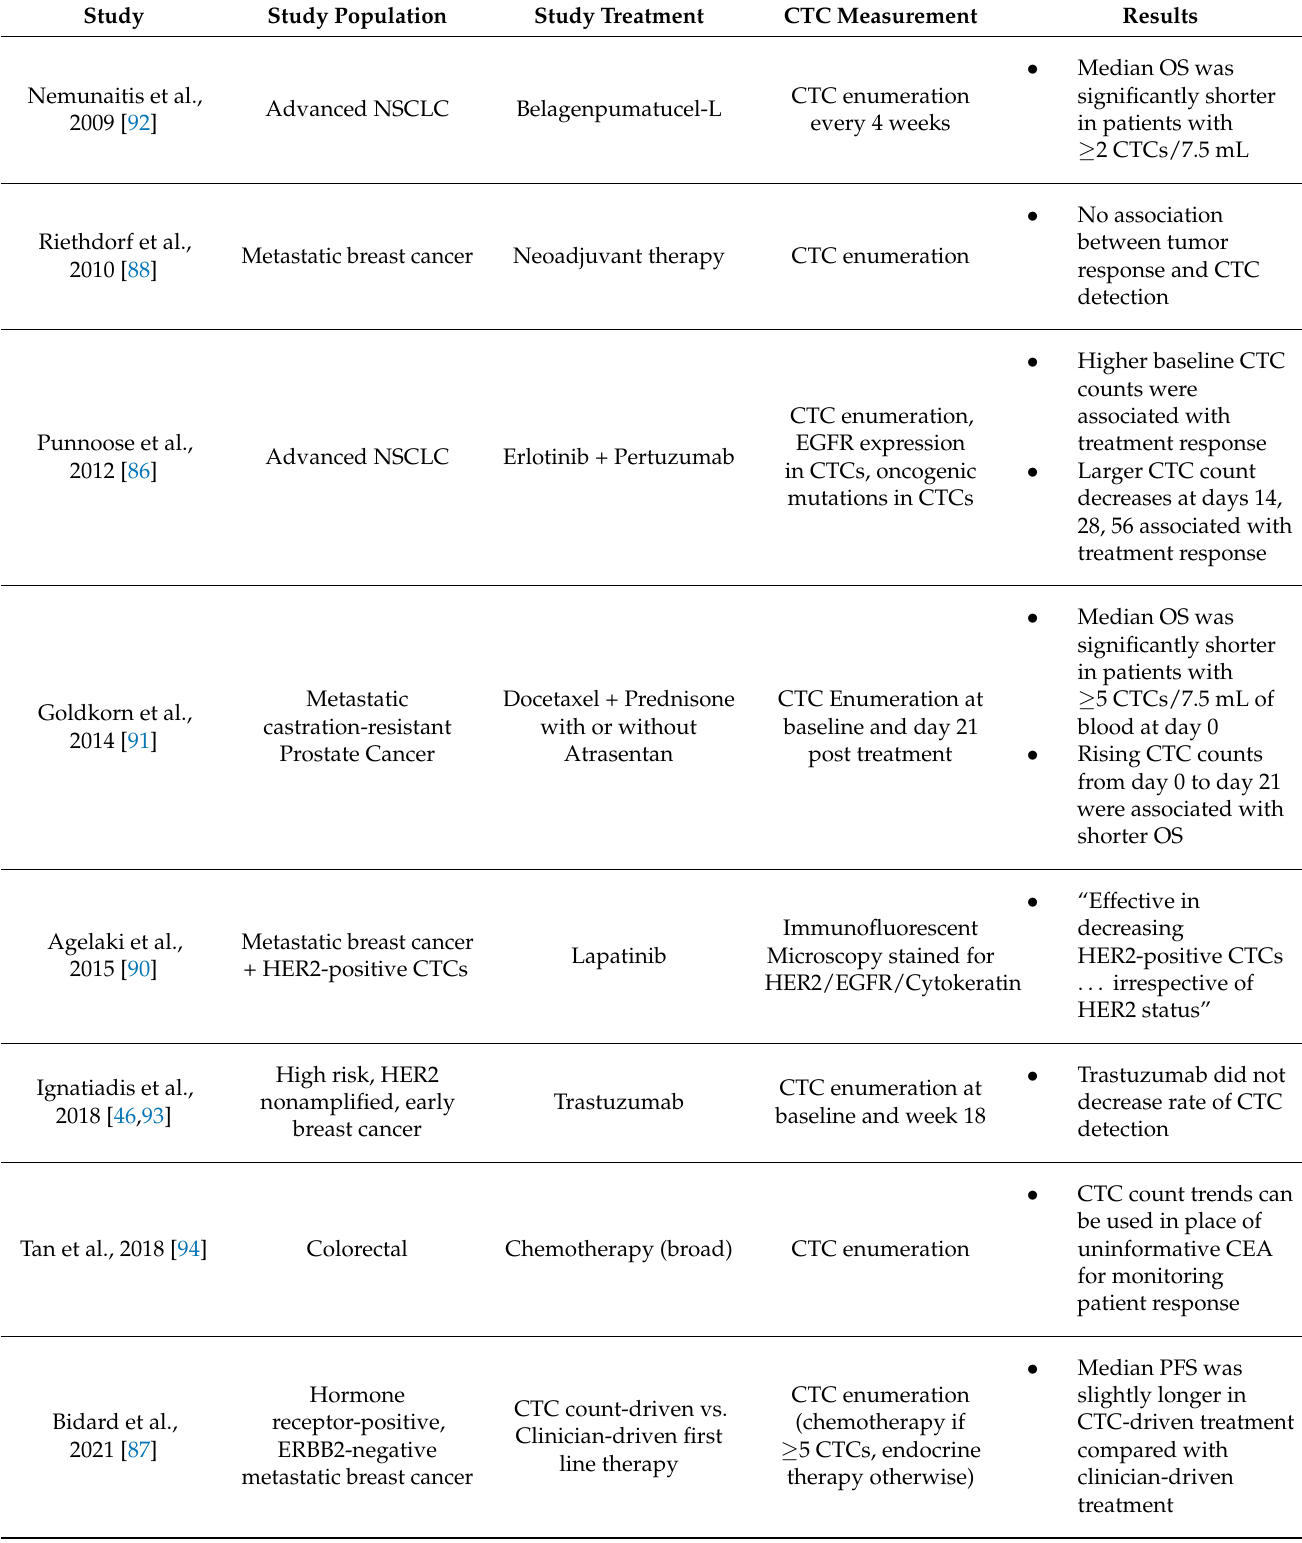
Table 2. CTCs in Clinical Disease